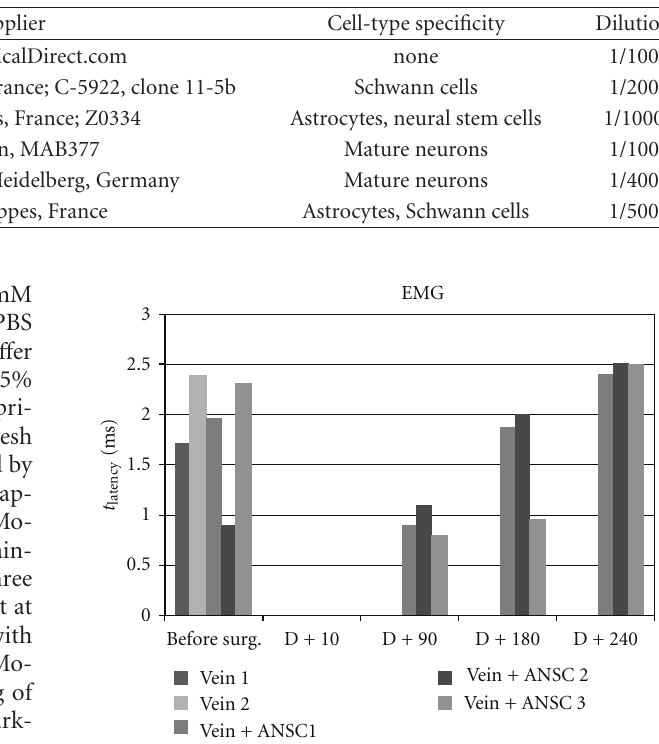
Table 1: List of primary antibodies used.